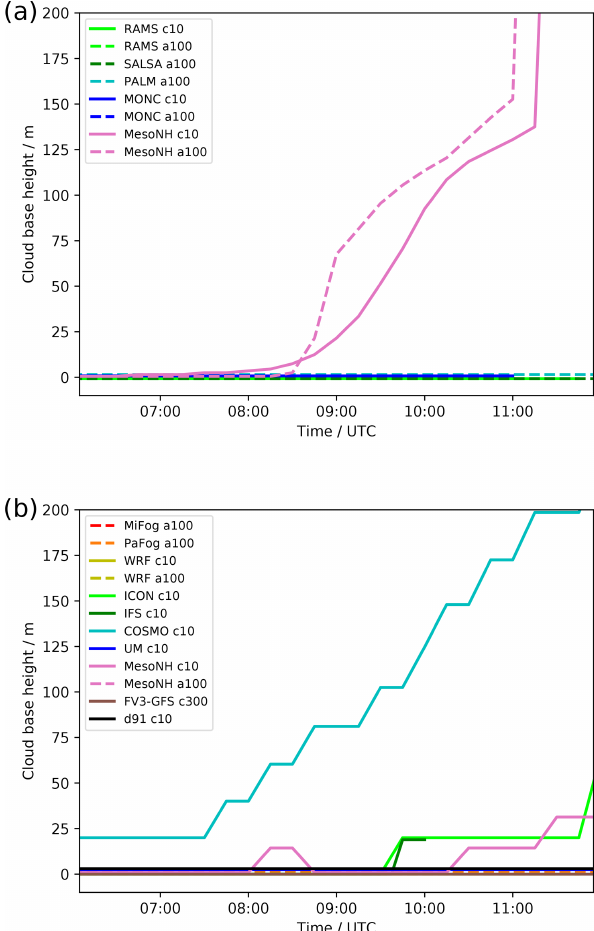
Figure 8. Surface downwelling short-wave radiation observed and modelled by (a) low aerosol/CDNC LES and (b) low aerosol/CDNC SCMs.